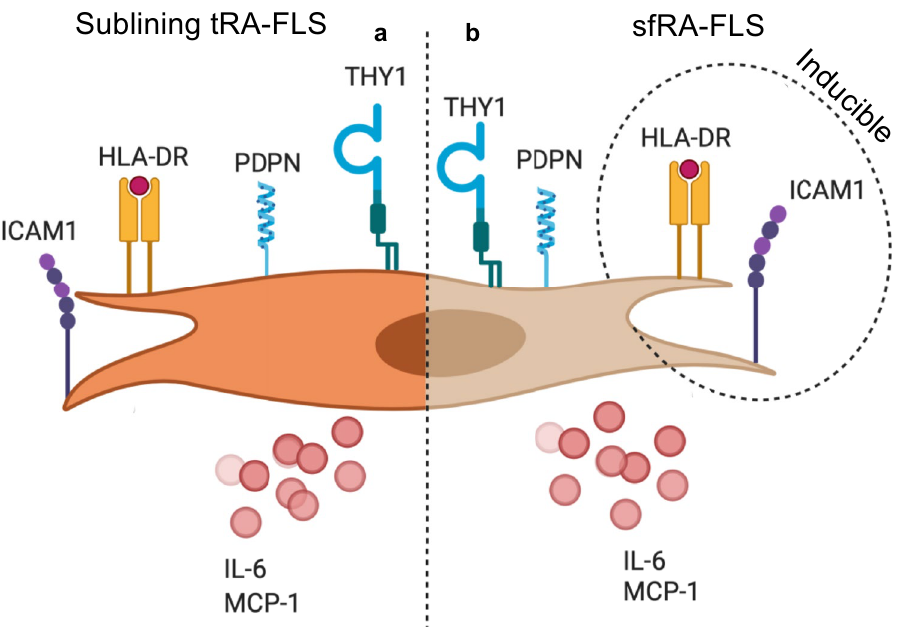
Figure 4. Similarities of pathological FLS harvested from the sublining layer or synovial fluid in RA. ( a ) A selection of subtype specific surface markers with corresponding dominated cytokine secretion. In general characterized by an upregulation of inflammatory pathways (transcriptomic profiling). ( b ) FLS harvested from the synovial fluid of flaring RA patients passaged in vitro displaying similar surface markers constantly or inducible, compatible cytokine secretion and increased joint destruction. Created with